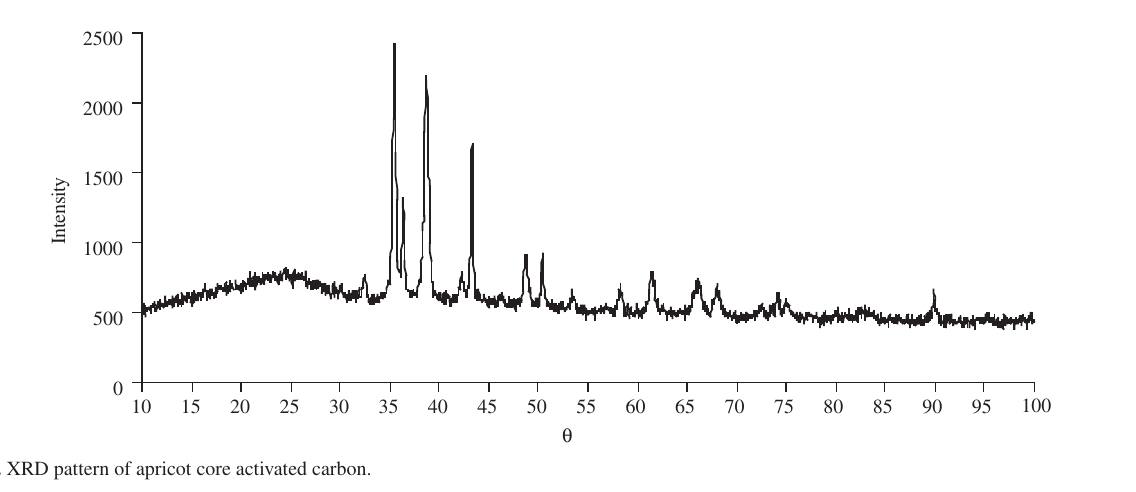
Figure 7. XRD pattern of apricot core activated carbon.